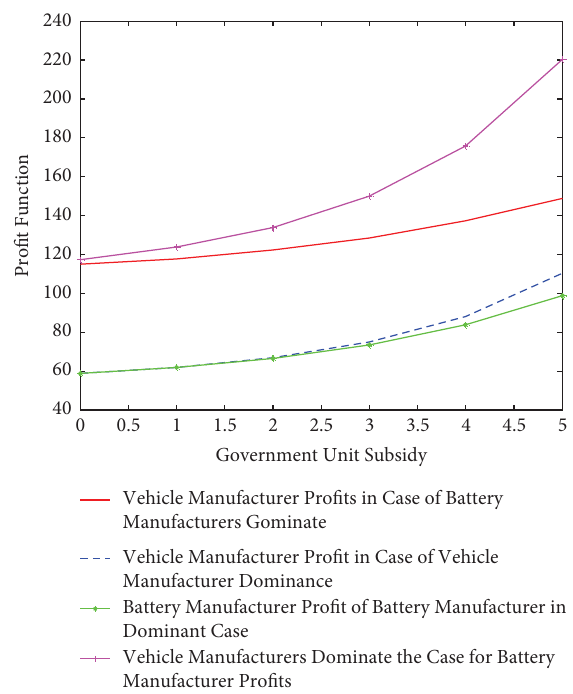
Figure 6: Te infuence of government subsidies on the proft of each subject under diferent power structures.